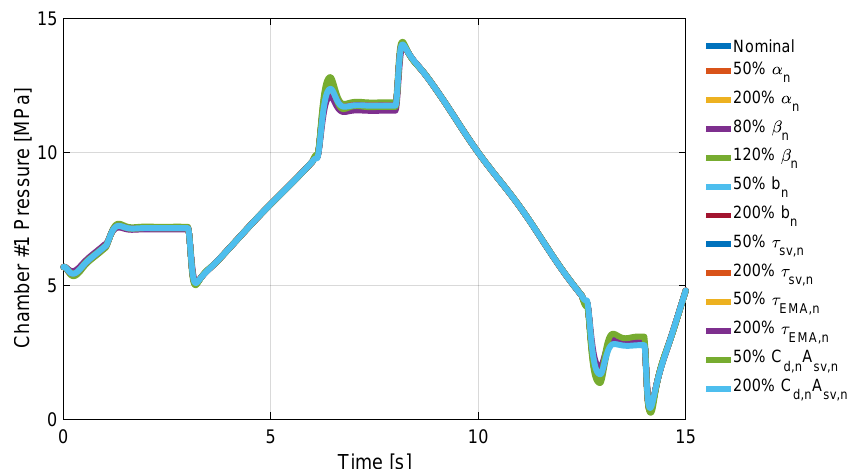
Figure 9. Simulation #1: Chamber #1 Pressure.